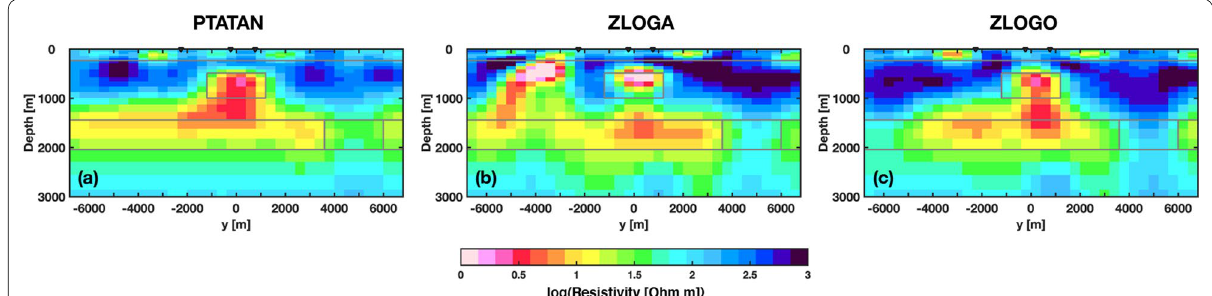
Fig. 25 NS cross sections at the easting of 200 m of the models inverted from the synthetic model (Fig. 1) with near‑surface distorters (Fig. 20) using different data types in the inversion, a PTATAN, b ZLOGO, and c ZLOGA, and using SSQ1D as the initial model (Fig. 24)